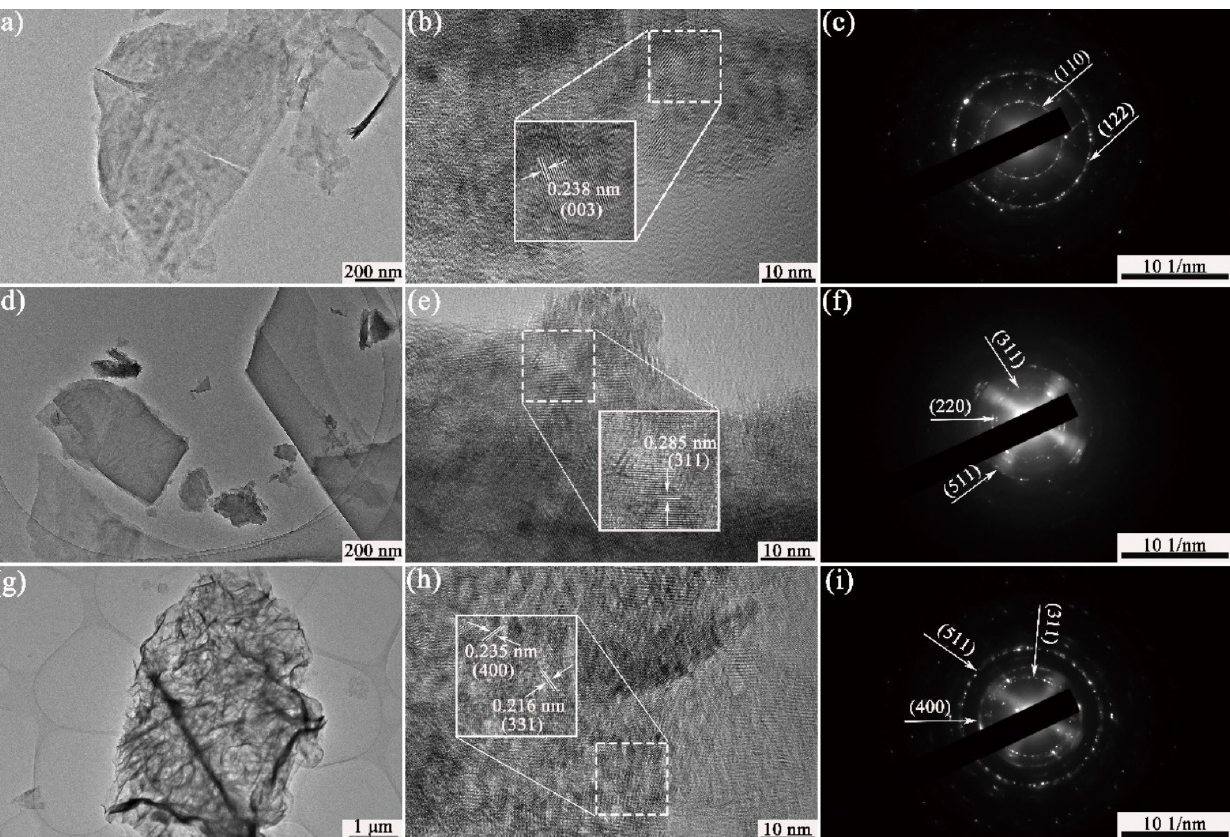
Figure 5. TEM, HRTEM, and SAED of the prepared samples: ( a – c ) Ni-S/NF; ( d – f ) Co-S/NF; ( g – i ) NiCo-S/NF.